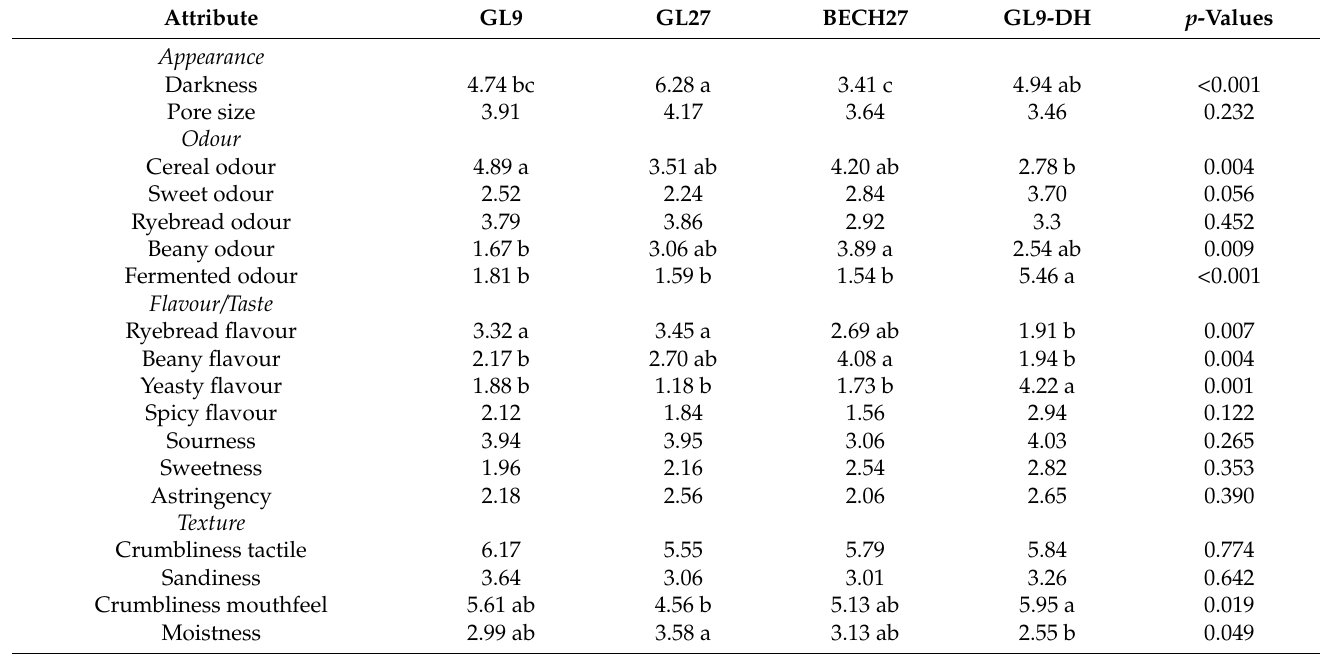
Table 5. Sensory profile analysis of the different breads: mean scores and Tukey’s post hoc groups.